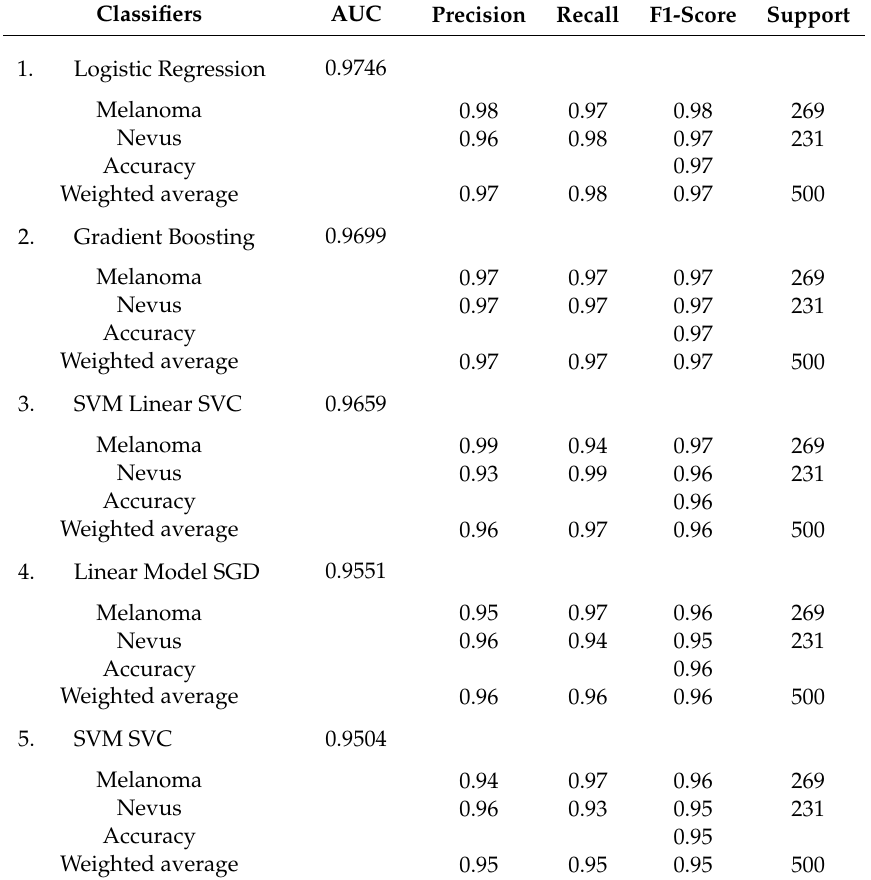
Table 2. Classifiers ordered by Area Under the Receiver Operating Characteristics